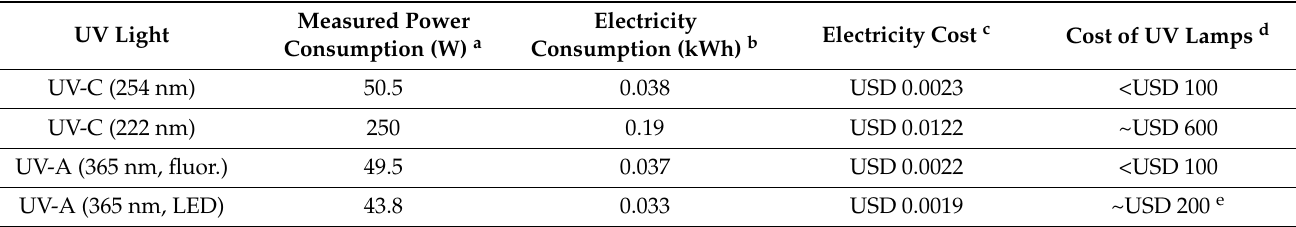
Table 4. Comparison of electricity cost (operational cost) among four different UV light types used for this laboratory-scale experiment.